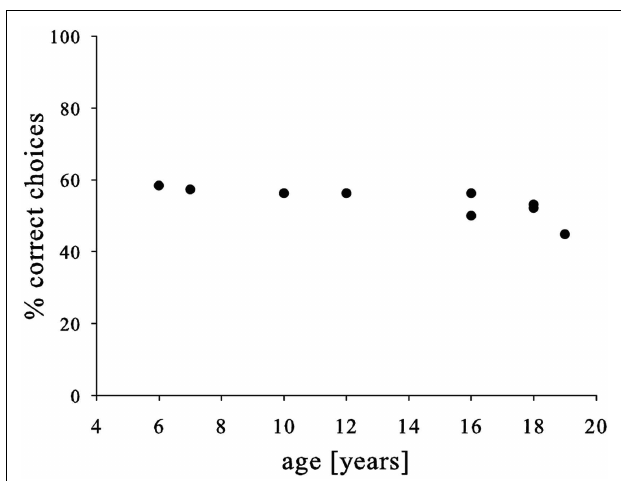
FIGURE 3 | Relationship between age of the subjects and choice